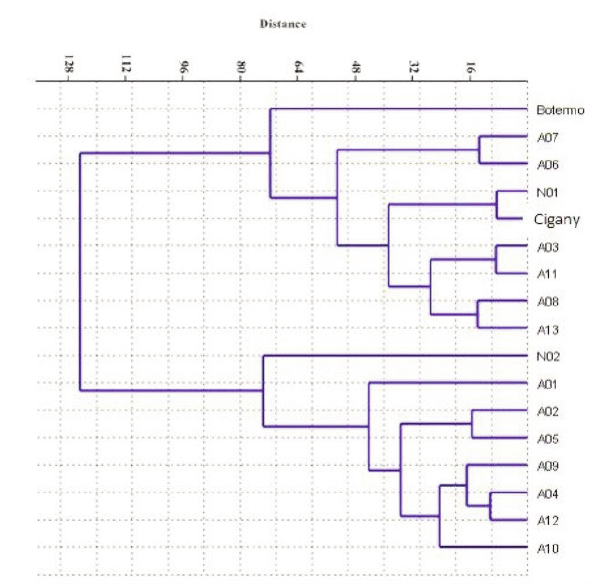
Fig. 1 - Dendrogram of 17 sour cherry genotypes based on morphological traits by PAST software.